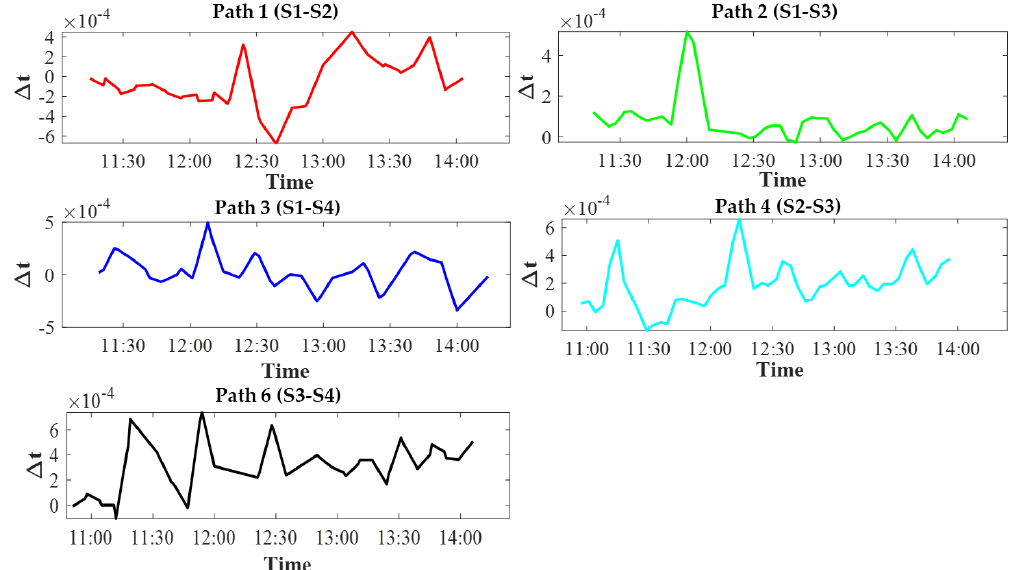
Figure 6. Time plots of the differential travel time for five station pairs.